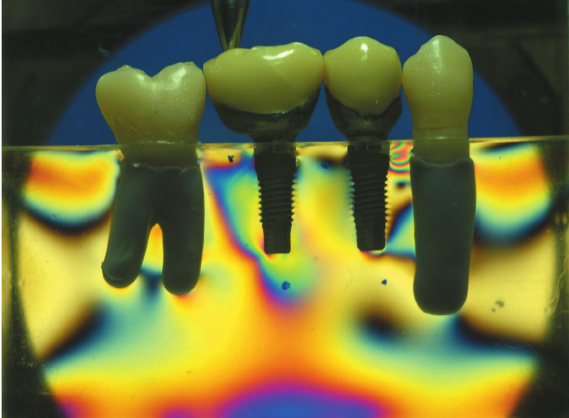
Figure 2- Vertical single point load (5 kgf) on the first molar (model with the second molar